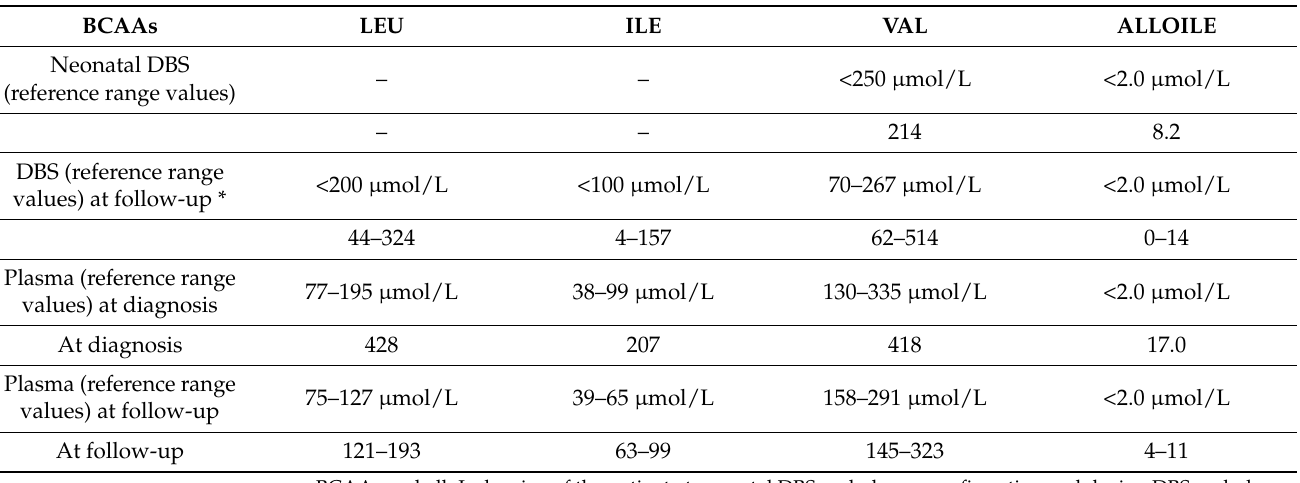
Table 1. DBS and plasma BCAAs and alloIsoleucine of the patient at diagnosis and